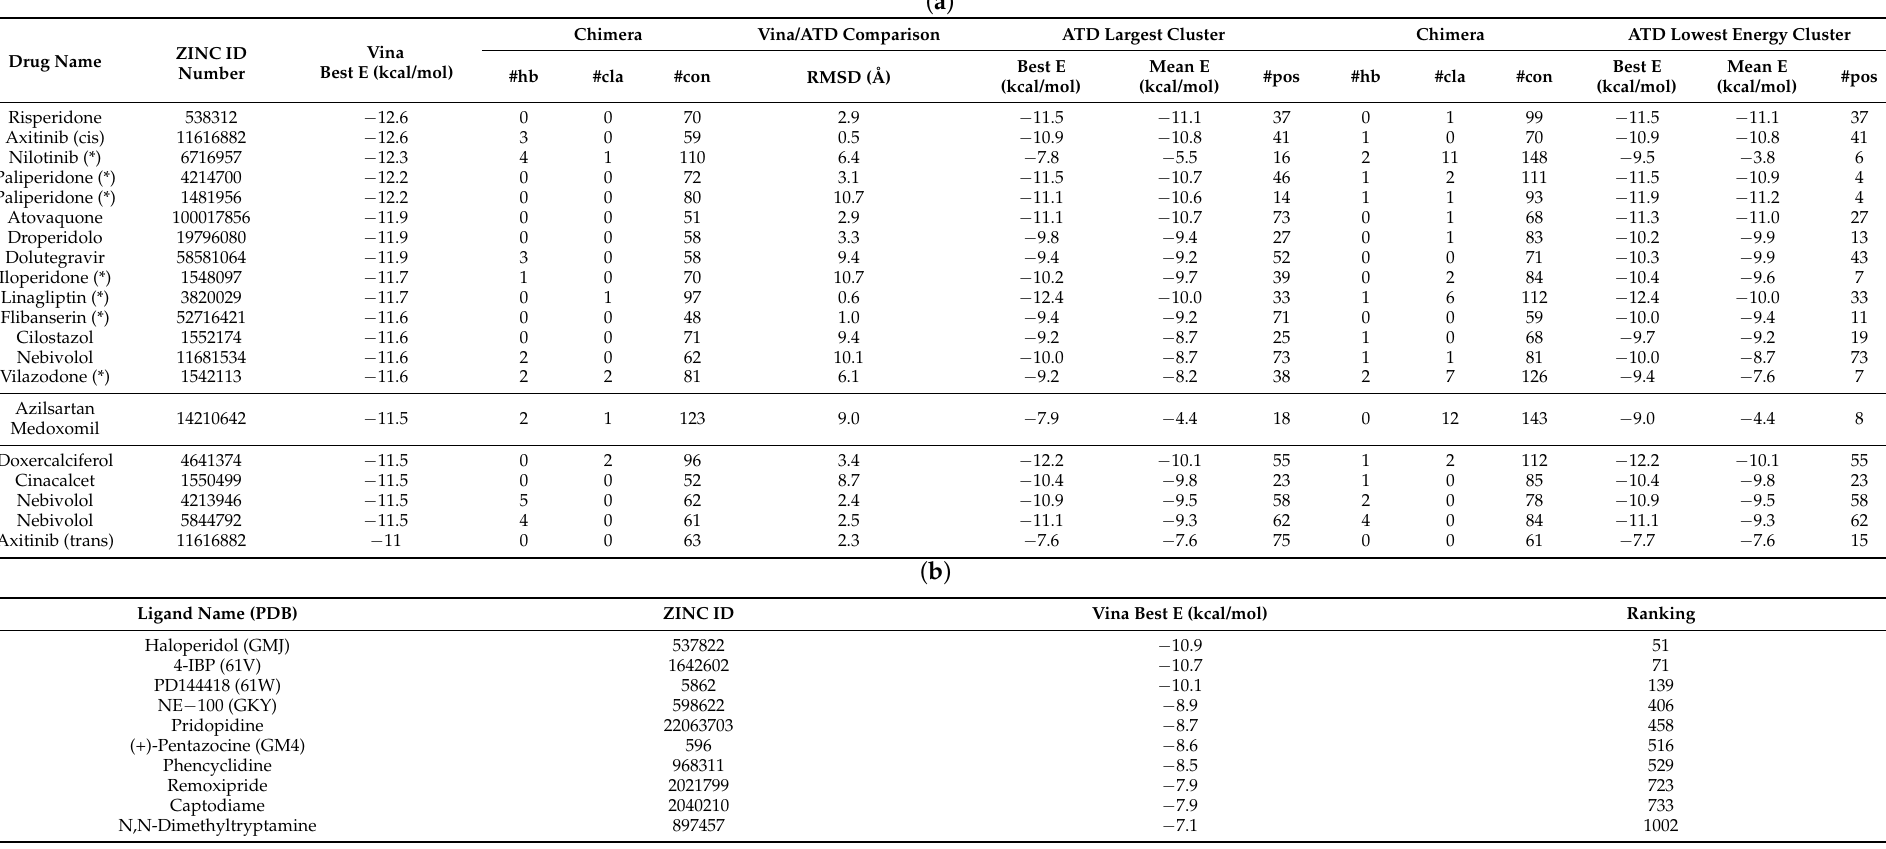
Table 2. Results of virtual screening and computational docking procedures. ( a ) Twenty FDA approved compounds having the best interaction energy with the σ 1R structure in coordinate file 5HK1_A. Vina Best E: energy of the ligand-receptor pose calculated by Vina. Autodock largest cluster and lowest energy cluster: Best E, Mean E and #pos represent the energy of the best pose in the cluster, the mean energy of the poses in the cluster and the number of poses in the cluster, respectively. #hb, #cla and #con: number of hydrogen bonds, clashes and contacts calculated by Chimera. Vina/Autodock RMSD (Å): root-mean square deviation (in angstroms) calculated after optimal superposition of the pose selected by Vina and the best pose of the largest cluster calculated by Autodock. Compounds selected for experimental validation by SPR are indicated by an asterisk (*). ( b ) Ranking and Best energy calculated by Vina for known σ 1R ligands in the compound library used for virtual screening. PDB ligand name: see Table